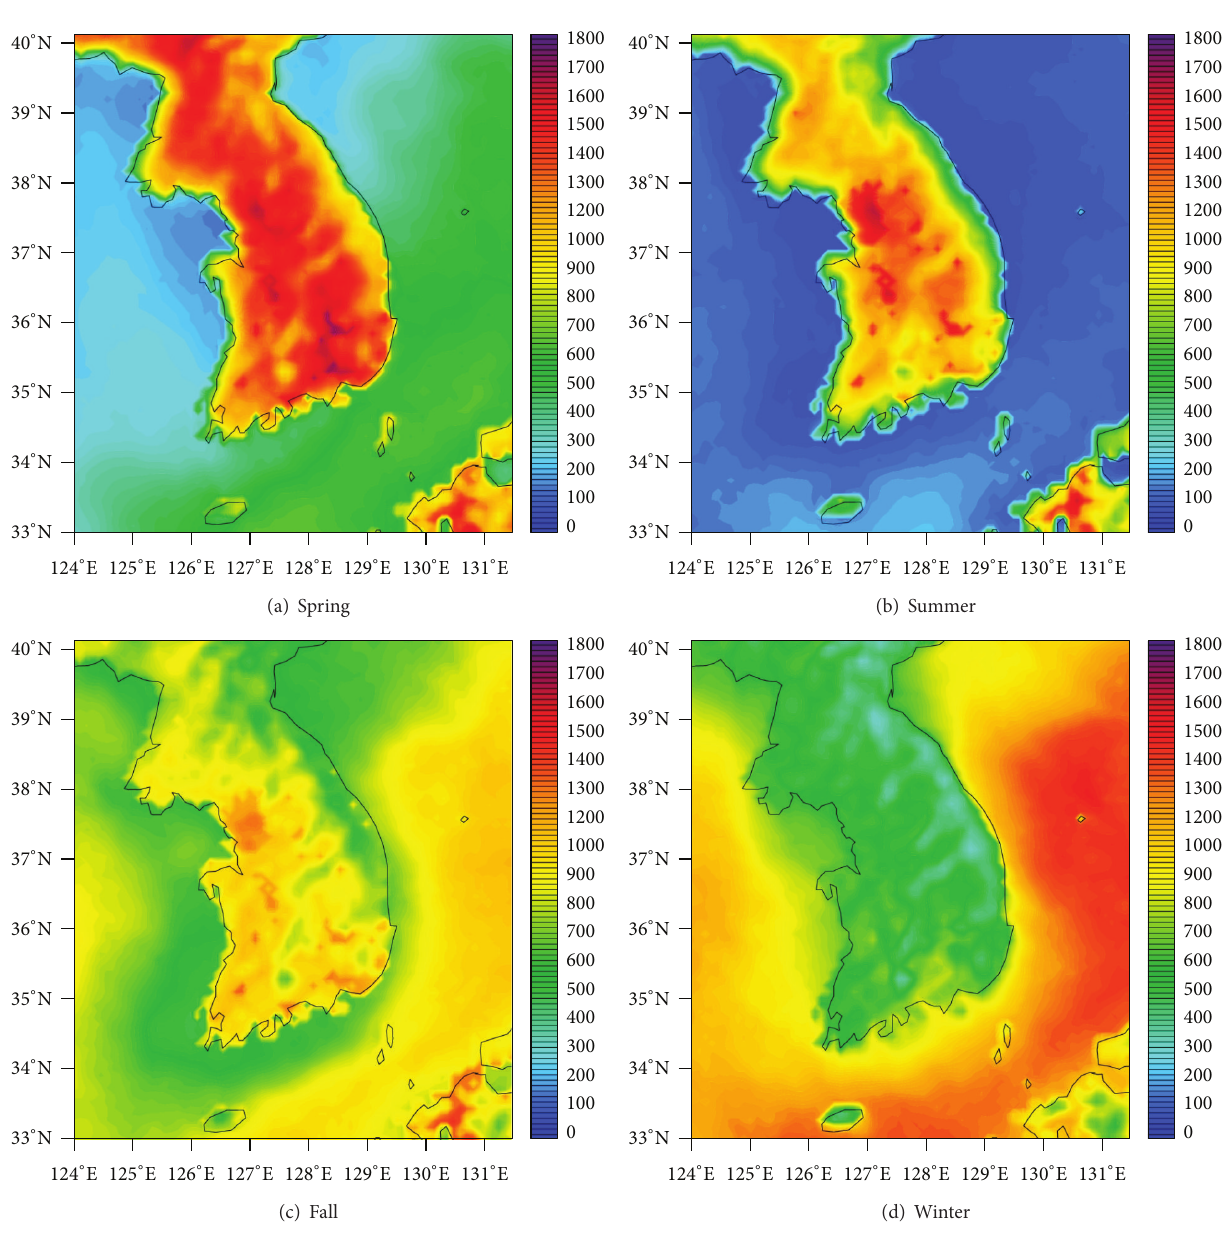
Figure 8: Seasonal mean distributions of the DMMH over the Southern Korean Peninsula and surrounding ocean during the period June 2010–May